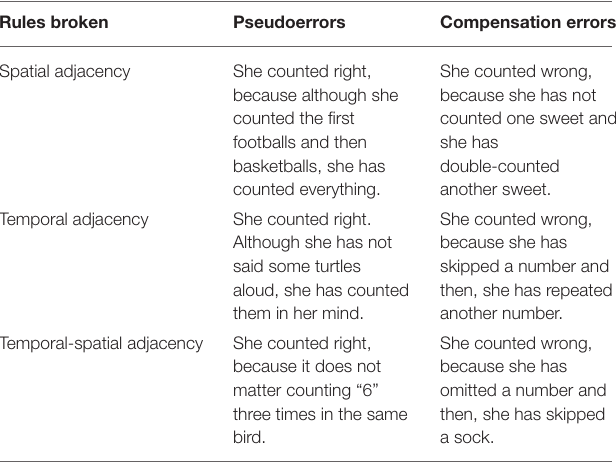
TABLE 3 | Description of the arguments offered by the teachers in the “with justification” condition in pseudoerrors and compensation errors. Rules broken Pseudoerrors Compensation